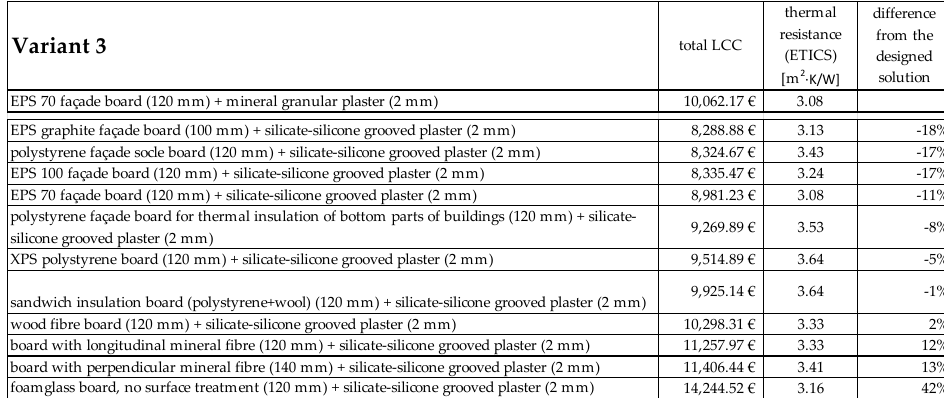
Figure 7. Output of the LCC calculation for Variant 3.